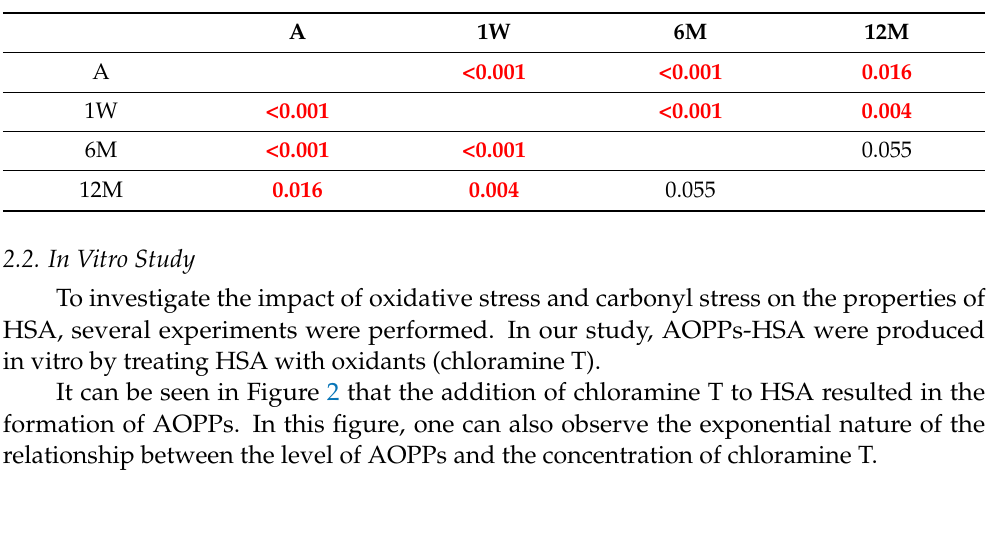
Table 2. The level of significance ( p -values) between the study group. A—COVID-19 patients